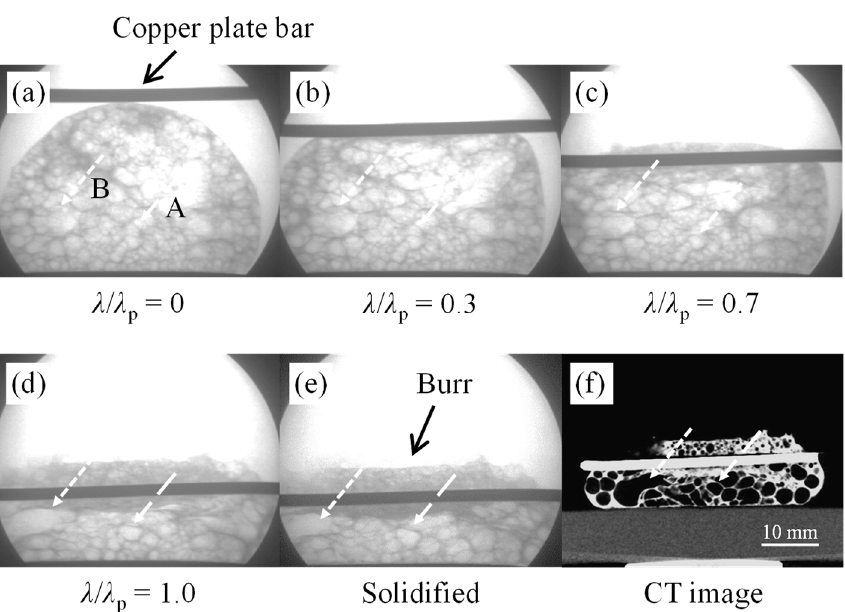
Figure 4. ( a – f ) X-ray transmission images of Sample I taken during press forming and X-ray CT image of obtained aluminum foam.